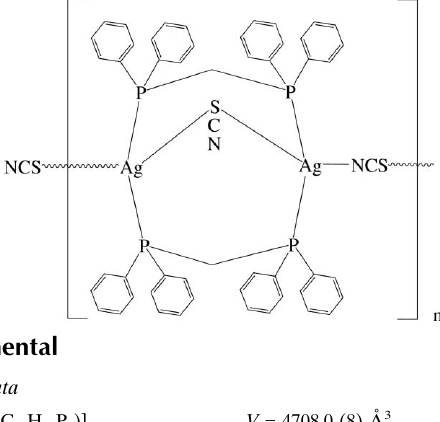
Experimental Crystal data